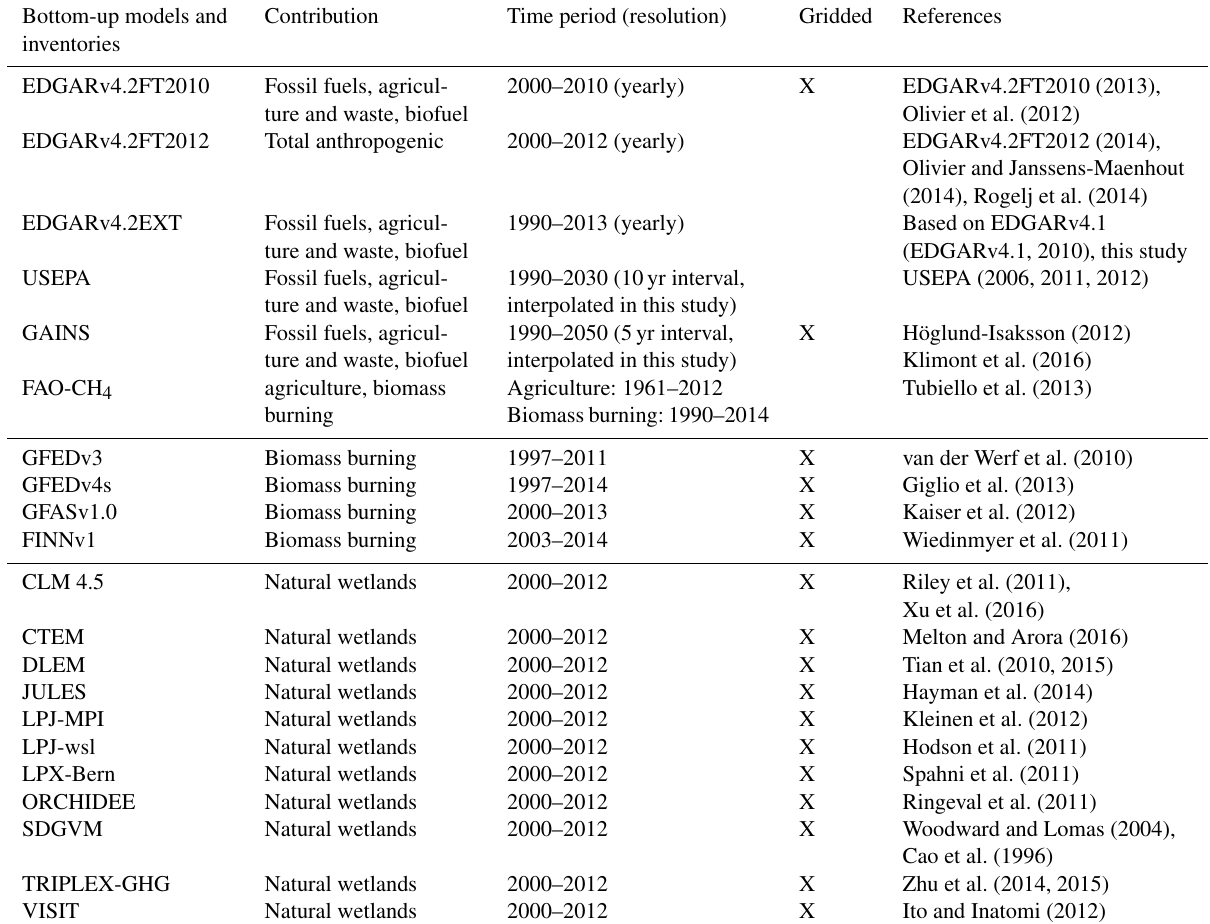
Table 1. Bottom-up models and inventories used in this study. Bottom-up models